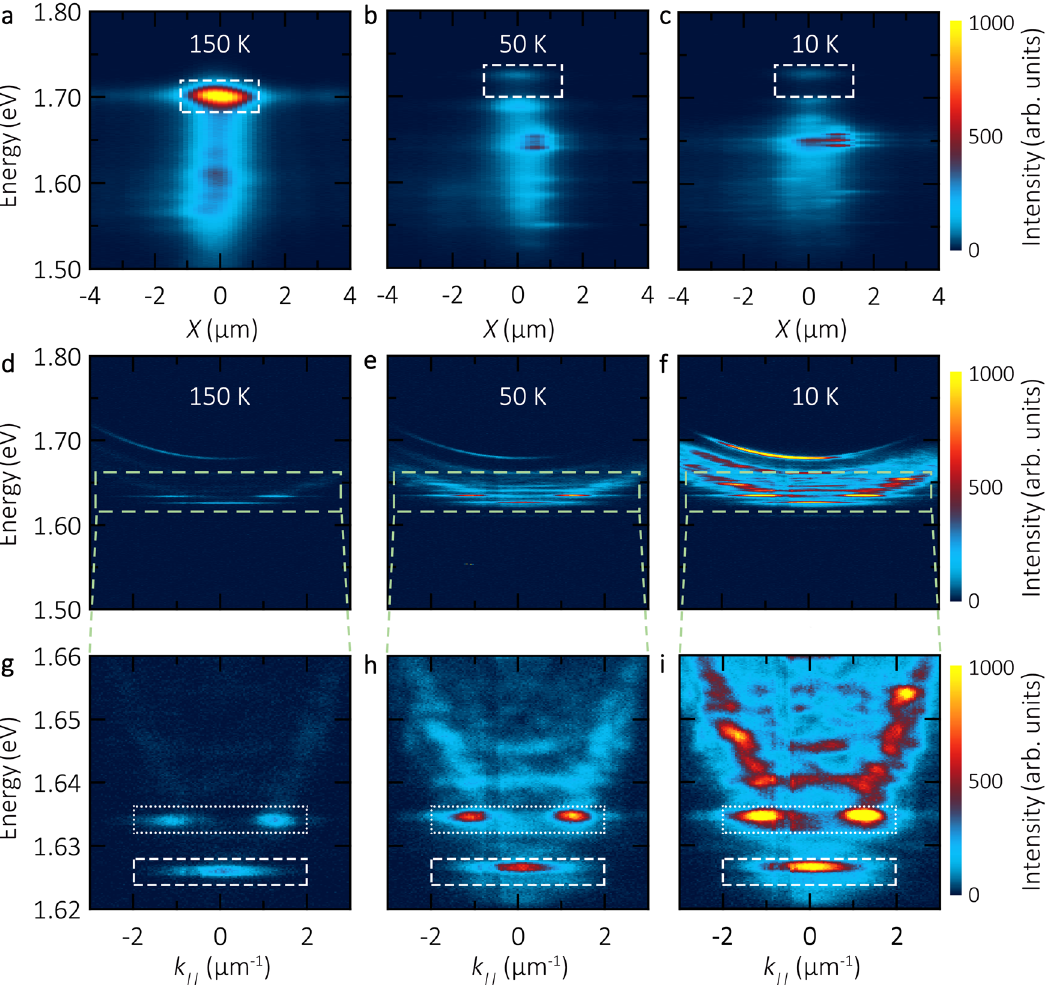
Fig. 3 Temperature-dependent PL of bare excitons and exciton-polaritons. a – c Real-space resolved PL intensity distribution of a pristine WSe 2 monolayer fl ake as a function of energy at temperatures 150, 50 and 10 K, respectively. The emission of bare excitons becomes dimmer as temperature decreases: the hallmark of a dark exciton ground-state. d – f Polariton dispersion relations recorded at 150, 50 and 10 K. In contrast to bare excitons, the LP luminescence signi fi cantly increases at low temperatures, behaving in the same manner as that of a bright material. g – i The zoom-in images of panels ( d – f ) in energy. The highlighted boxes are analysis regions of integrated intensity in Fig. 4.